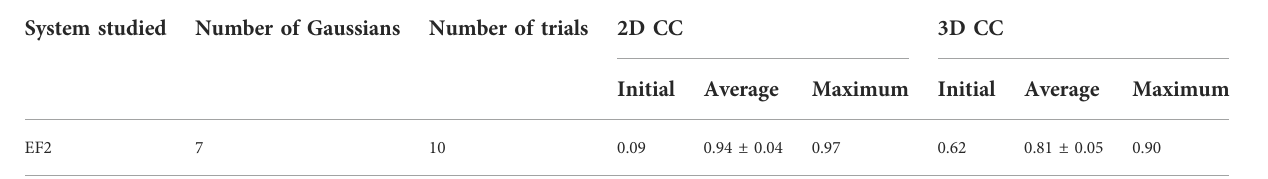
TABLE 4 Summary of the EF2 modeling